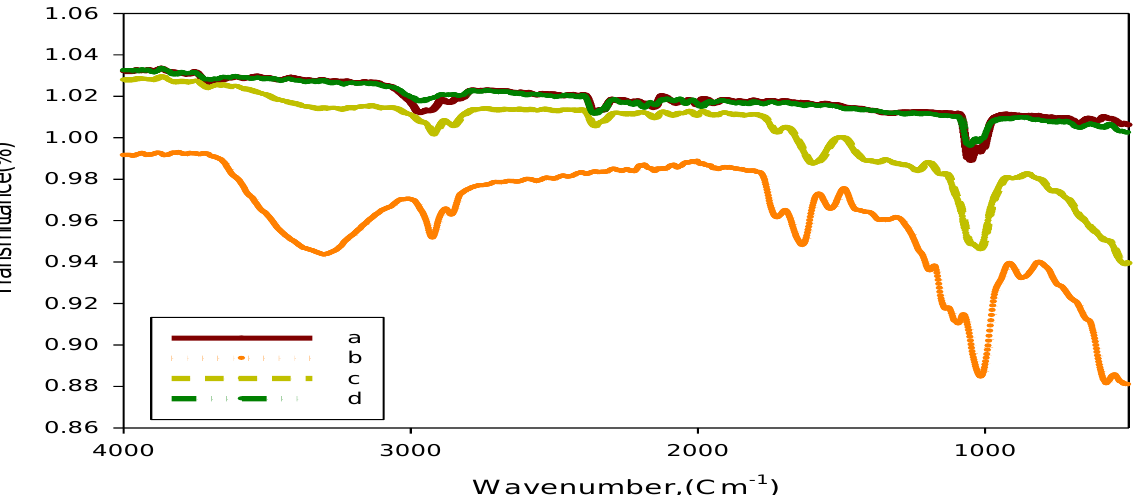
Figure 7. ZnO nanoparticles FT-IR spectra of; (a) ZnO nanoparticles (black colour), (b) PNC (rouge colour), (c) chlorophyll/ZnO nanoparticles (yellow colour), and (d) chlorophyll/ZnO nanoparti- cles/PNC (green colour).